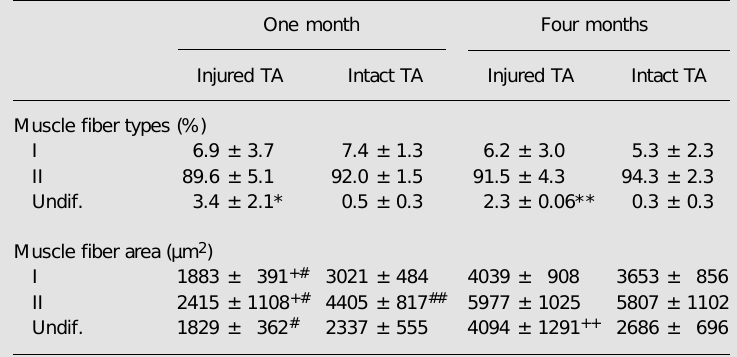
Table 2. Type I, II and undifferentiated (Undif.) muscle fibers and area of muscle fibers of the one- and four-month groups of